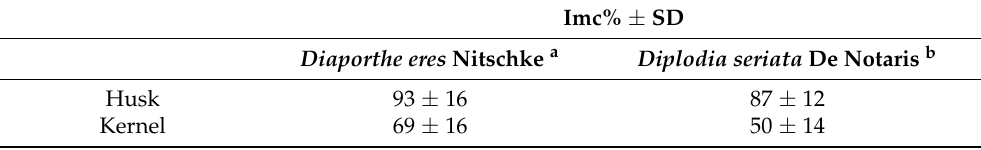
a Values represent the mean of five isolates ± standard deviance of the mean. b Values represent the mean of five isolates ± standard deviance of the